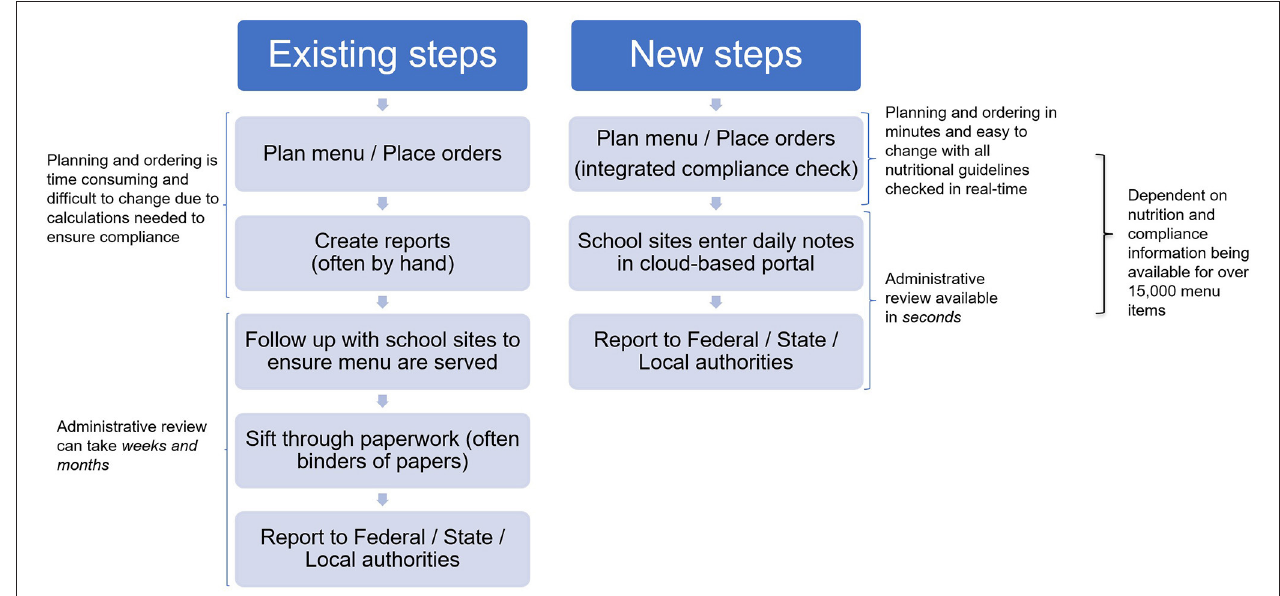
FIGURE 1 | Summary of nutrition planning and reporting steps for foodservice directors and school food